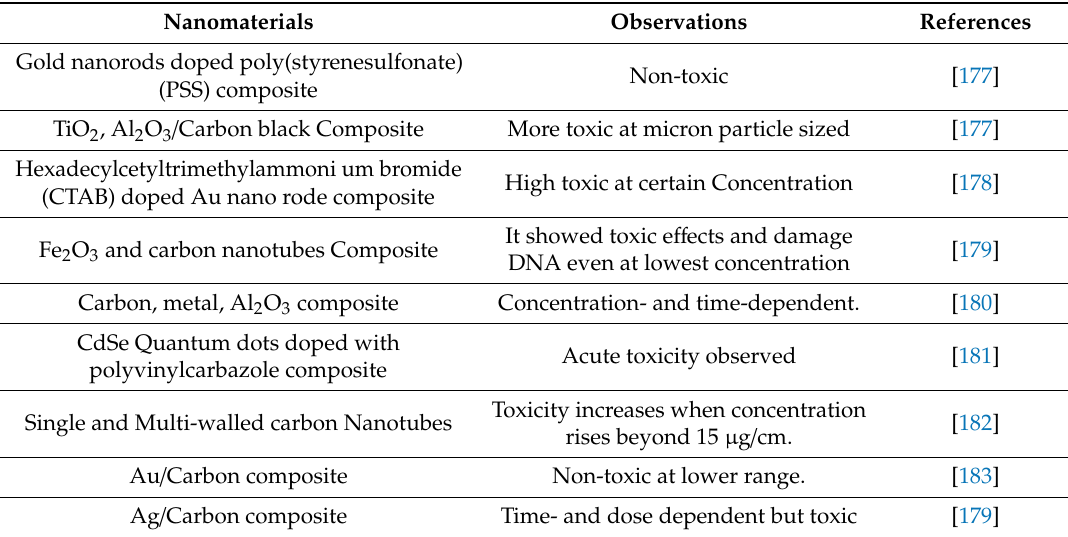
Table 6. Observation of self-toxic effect of some common nanomaterials.